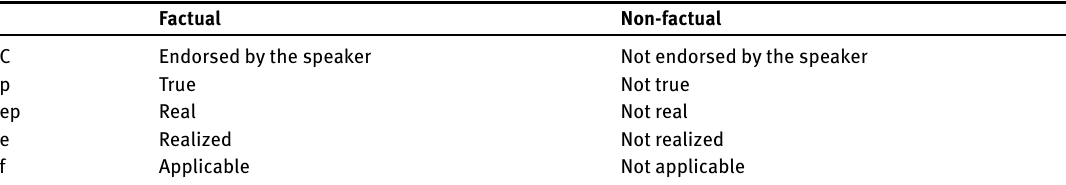
Table 2. Factuality parameter (Hengeveld 2014, Hengeveld in prep.)